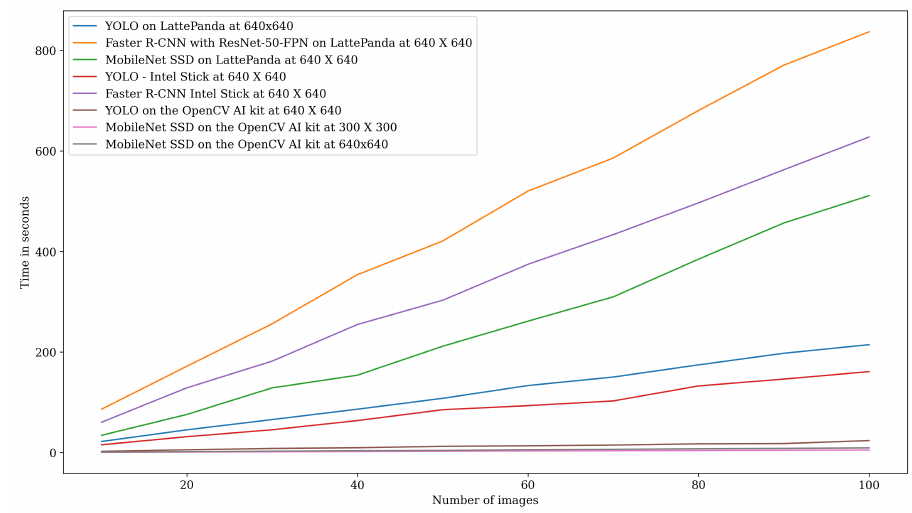
Figure 12. Time taken to perform wheat detection on various platforms.